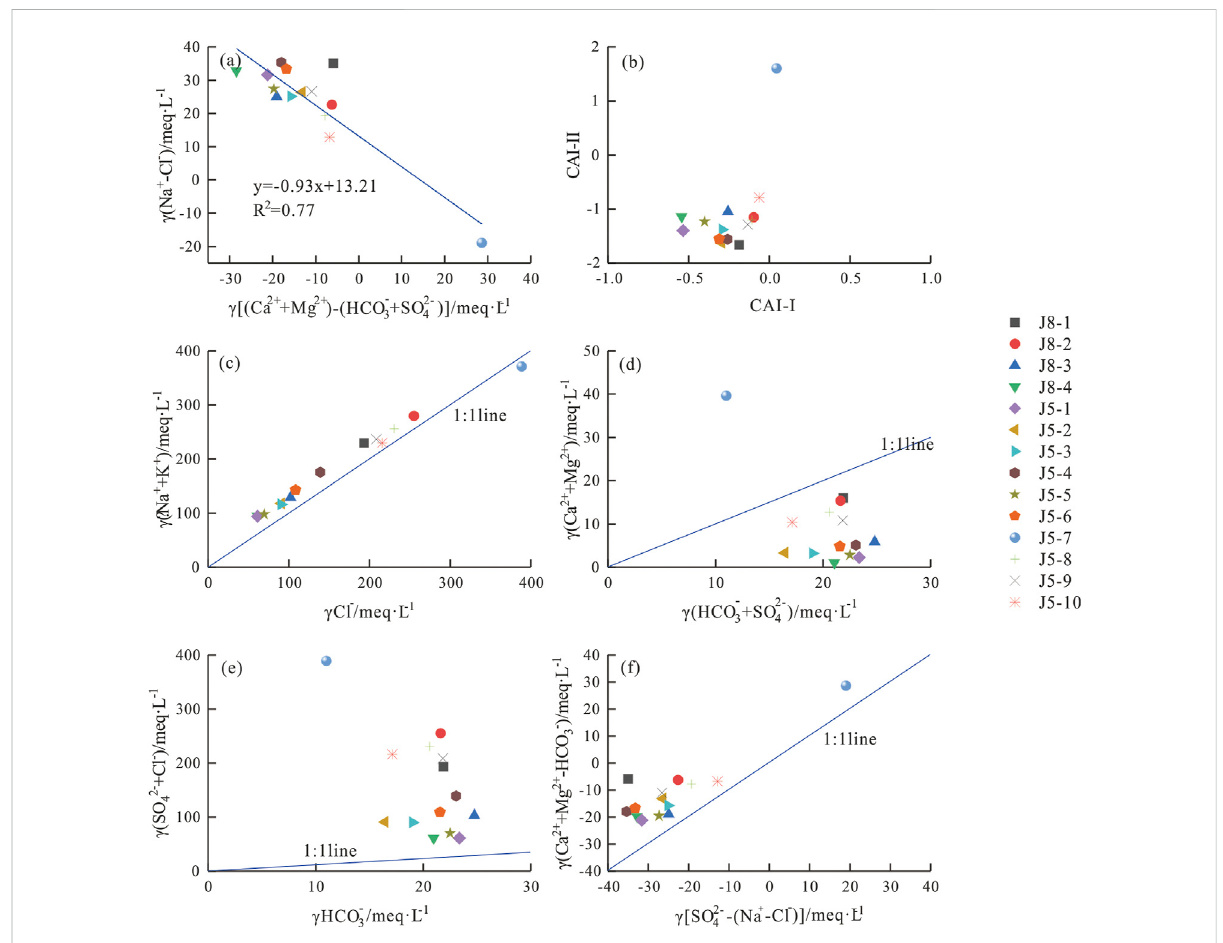
FIGURE 5 Relationship between hydrochemical compositions: (A) molar ratio of [(Ca 2+ +Mg 2+ )-(HCO 3 − +SO 4 2- )] vs. (Na + -Cl - ); (B) chloro-alkaline indices (CAI); (C) molar ratio of (Cl − ) vs. (Na + +K + ); (D) molar ratio of (HCO 3 − +SO 4 2- )vs. (Ca 2+ +Mg 2+ ); (E) molar ratio of (HCO 3 − ) vs. (SO 4 2- +Cl − ); (F) molar ratio of [SO 4 2- -(Na + -Cl − )] vs. (Ca 2+ +Mg 2+ -HCO 3 - ). The ionic unit is meq/L (modi fi ed from Bao et al.,